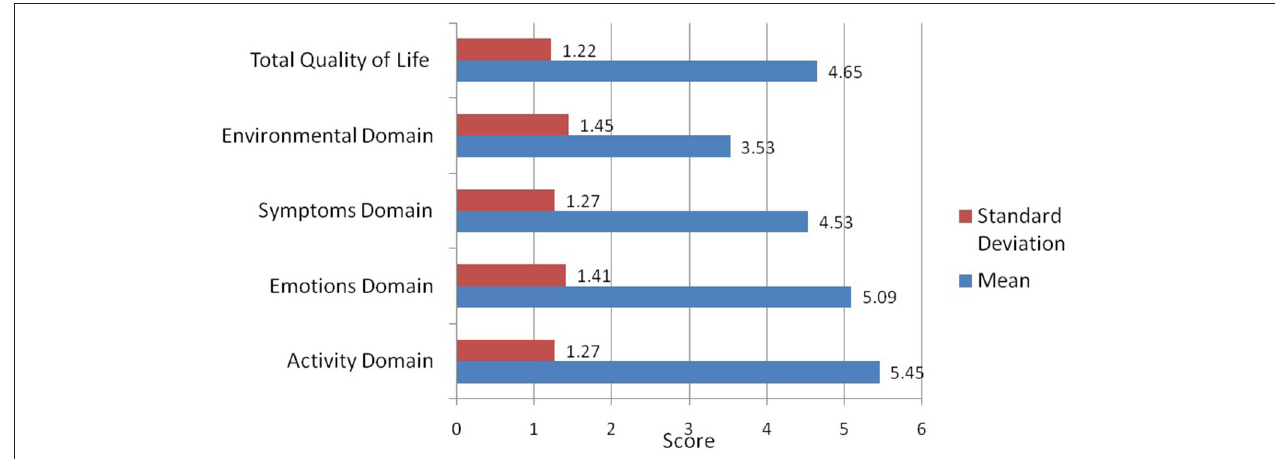
FIGURE 1 | Means and standard deviation of the Quality of life scale and subscales